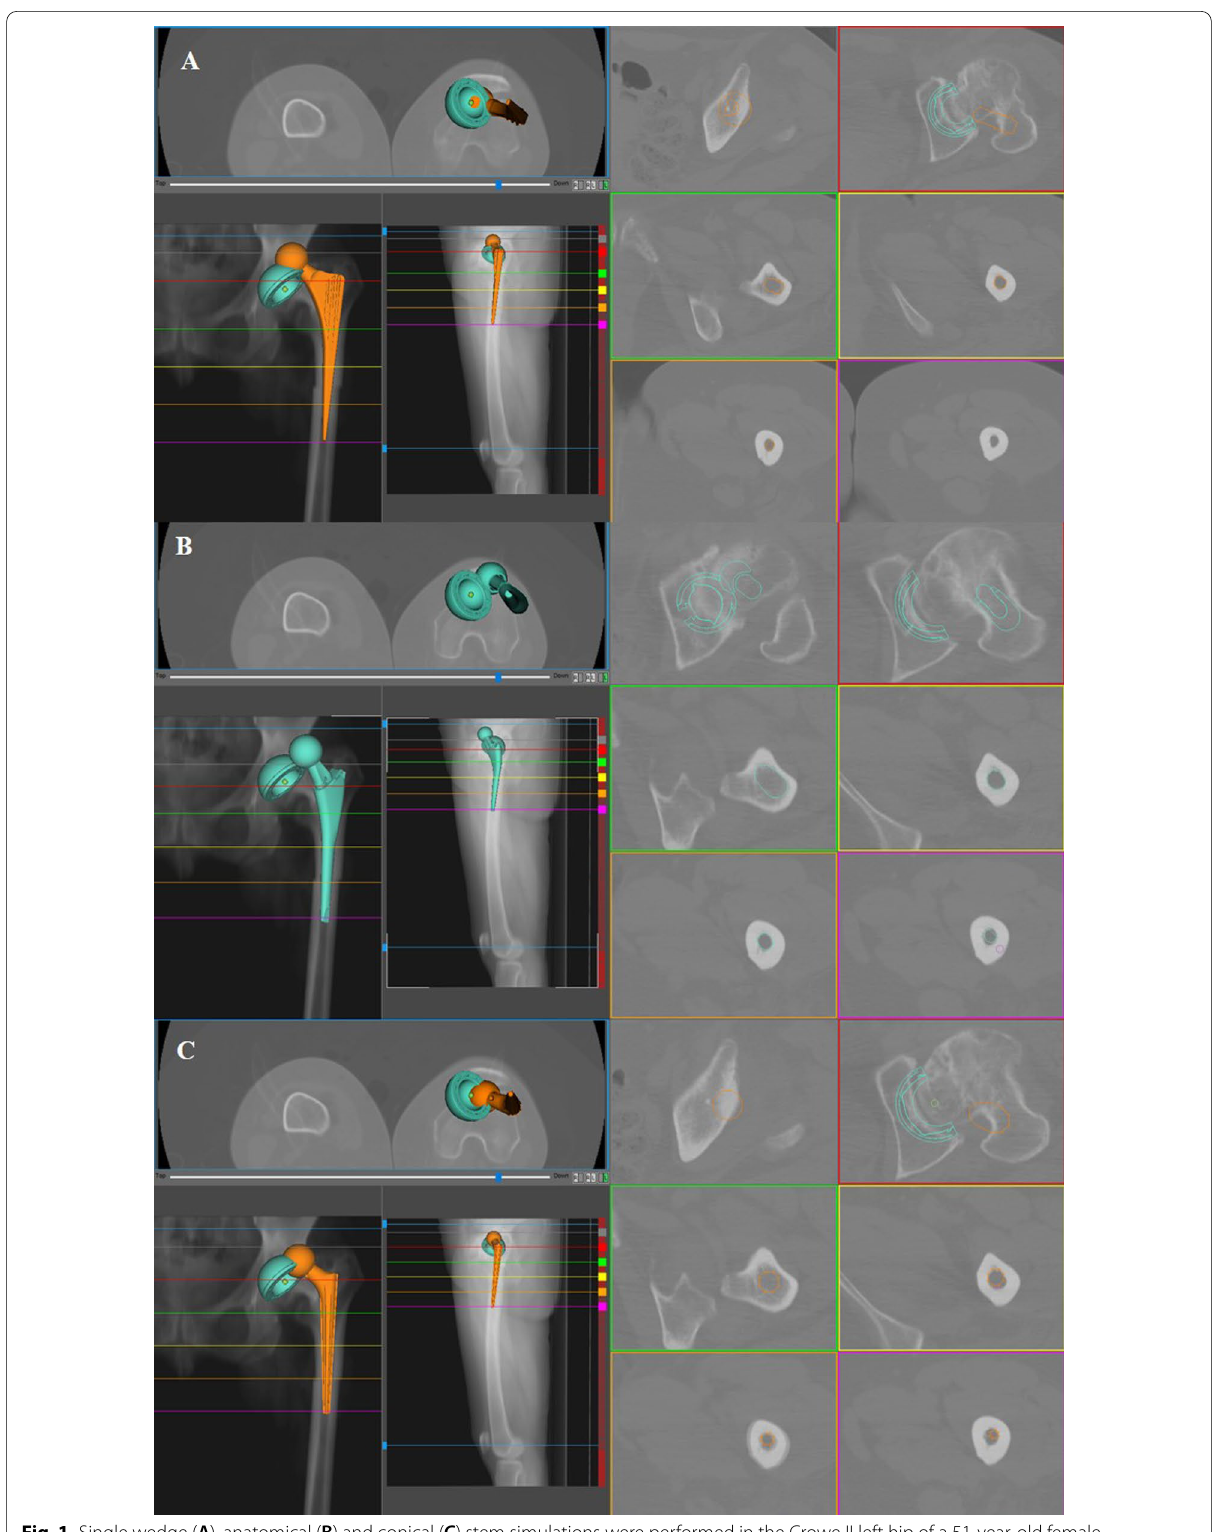
Fig. 1 Single wedge ( A ), anatomical ( B ) and conical ( C ) stem simulations were performed in the Crowe II left hip of a 51-year-old female (native femoral anteversion 24°). Single wedge and anatomical stems did not achieve the targeted combined anteversion, whereas the conical stem was deemed